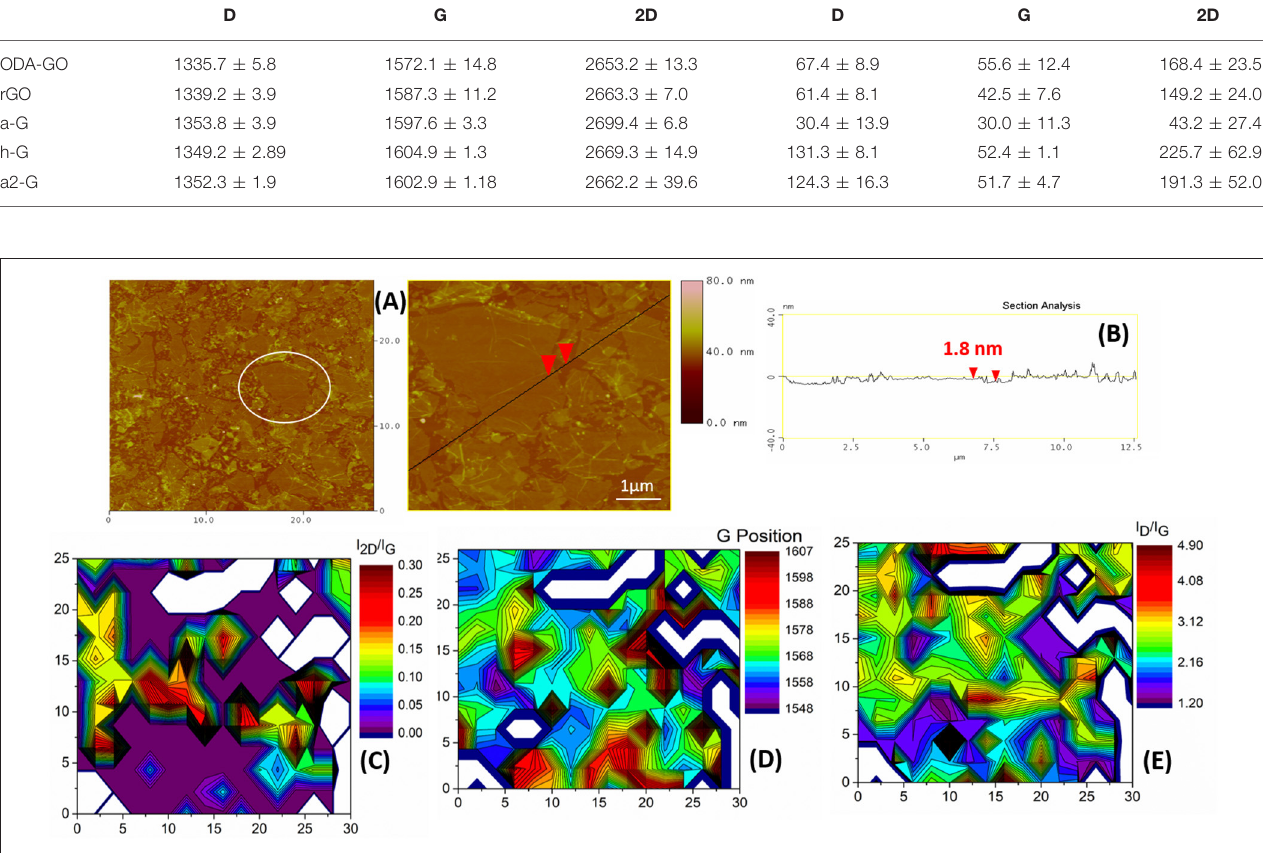
FIGURE 5 | ODA-GO flakes deposited onto the Si substrate. (A) A low magnification AFM image (left) of the flake size distribution. The white circle highlights the area of the high magnification image (right). The black line and the red arrows indicate the section and point of measurement, respectively for (B) , which is a section analysis with an indicative height measurement. (C) Raman 2D contour plot of the I 2D /I G . (D) Raman 2D contour plot of the G position. (E) Raman 2D contour plot of the I D /I G ratio. Axis dimensions in all Raman plots are in µ